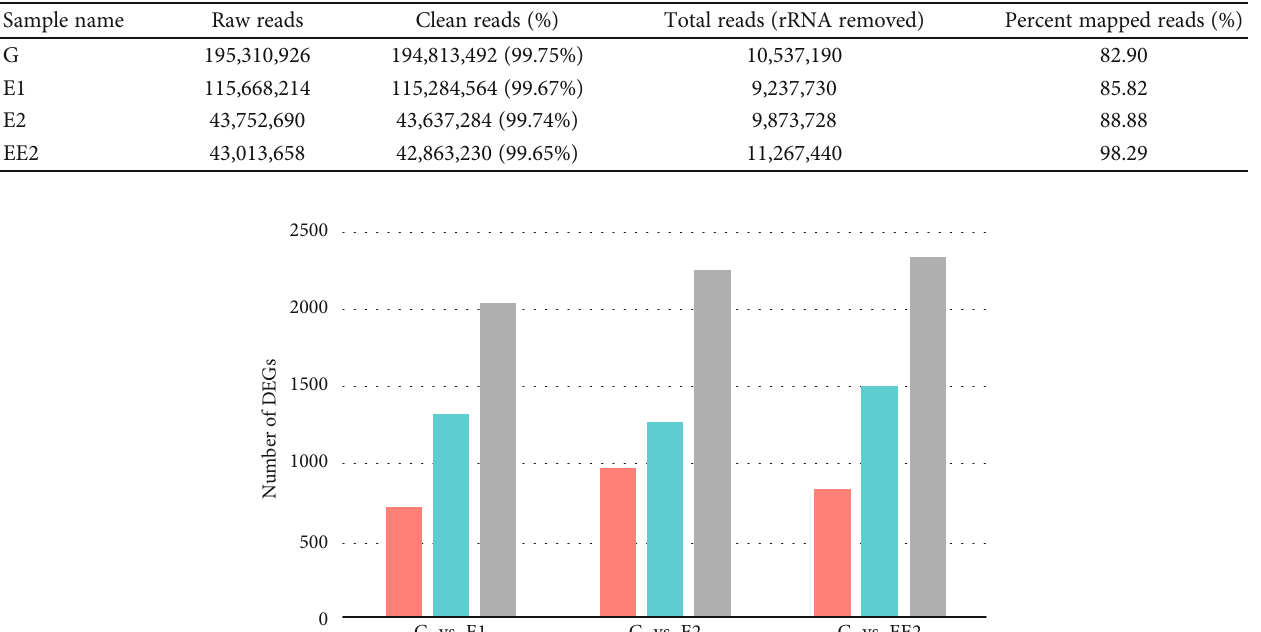
Table 1: Transcriptome sequence data after fi ltering and mapping to the reference